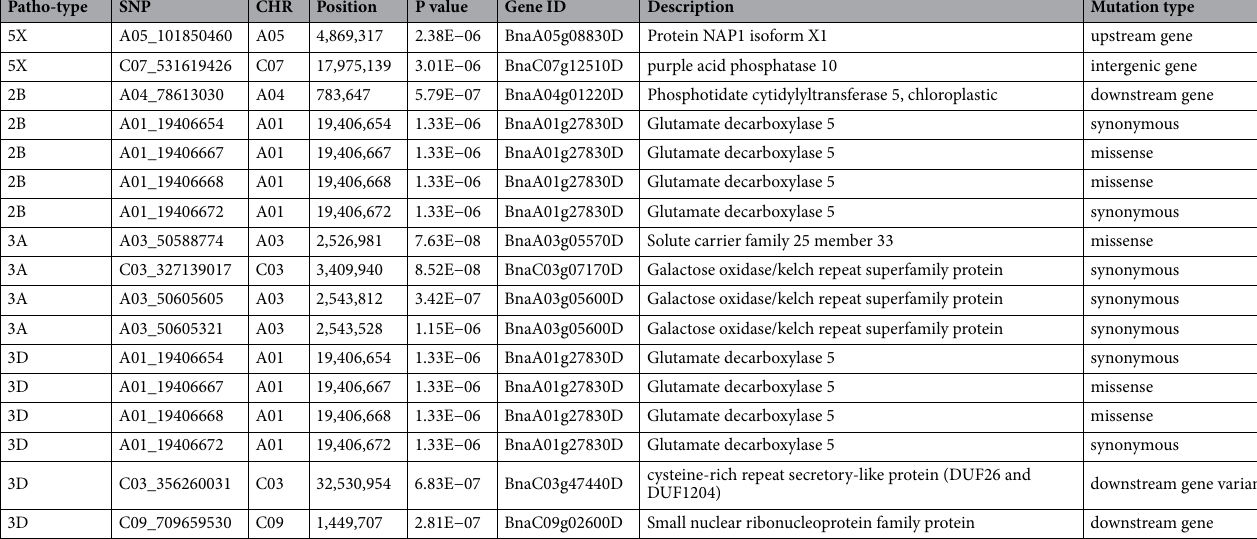
Table 3. List of significant SNPs, chromosomes, physical location, P values, gene ID, description, and mutation type in 117 accessions of Brassica napus.